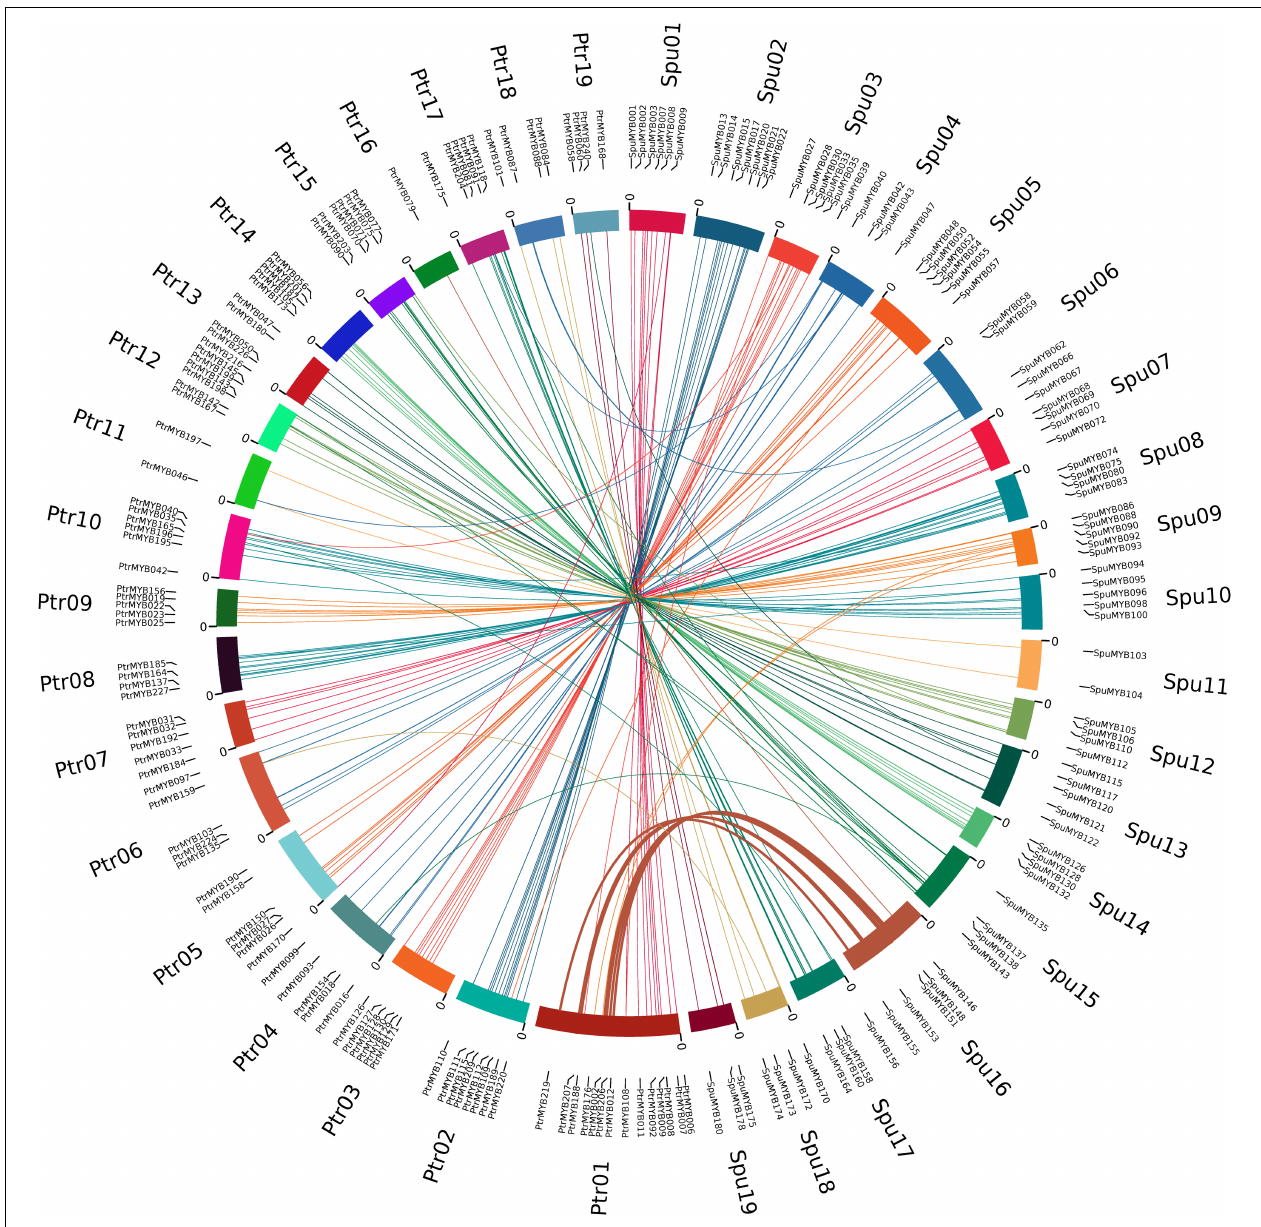
FIGURE 3 | Duplication event analysis of R2R3 MYB genes and comparative synteny analysis between poplar and willow. Circos diagram showing gene positions of 166 orthologous gene pairs on poplar and willow chromosomes, Ptr01-Ptr18 represents 18 poplar chromosomes and Spu01-Spu18 represents 18 willow chromosomes. Orthologous gene pairs are located on a chromosome and connected with a line of the same color as the corresponding chromosome. The size of the chromosome is consistent with the size of the actual pseudochromosome. Positions are in